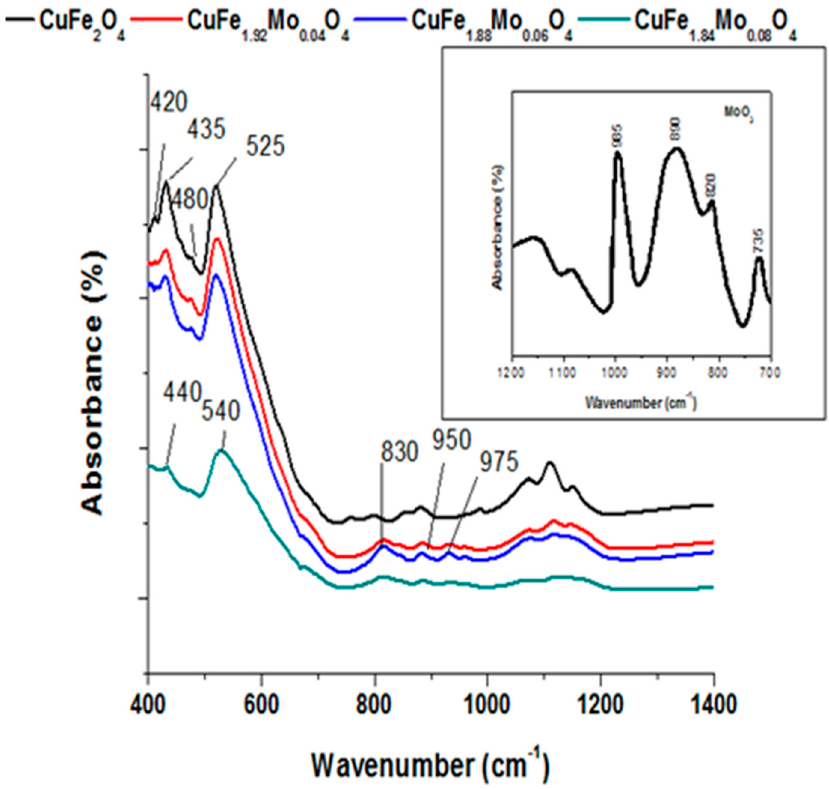
Figure 2. FT-IR spectra of the copper ferrites dopped with molybdenum.